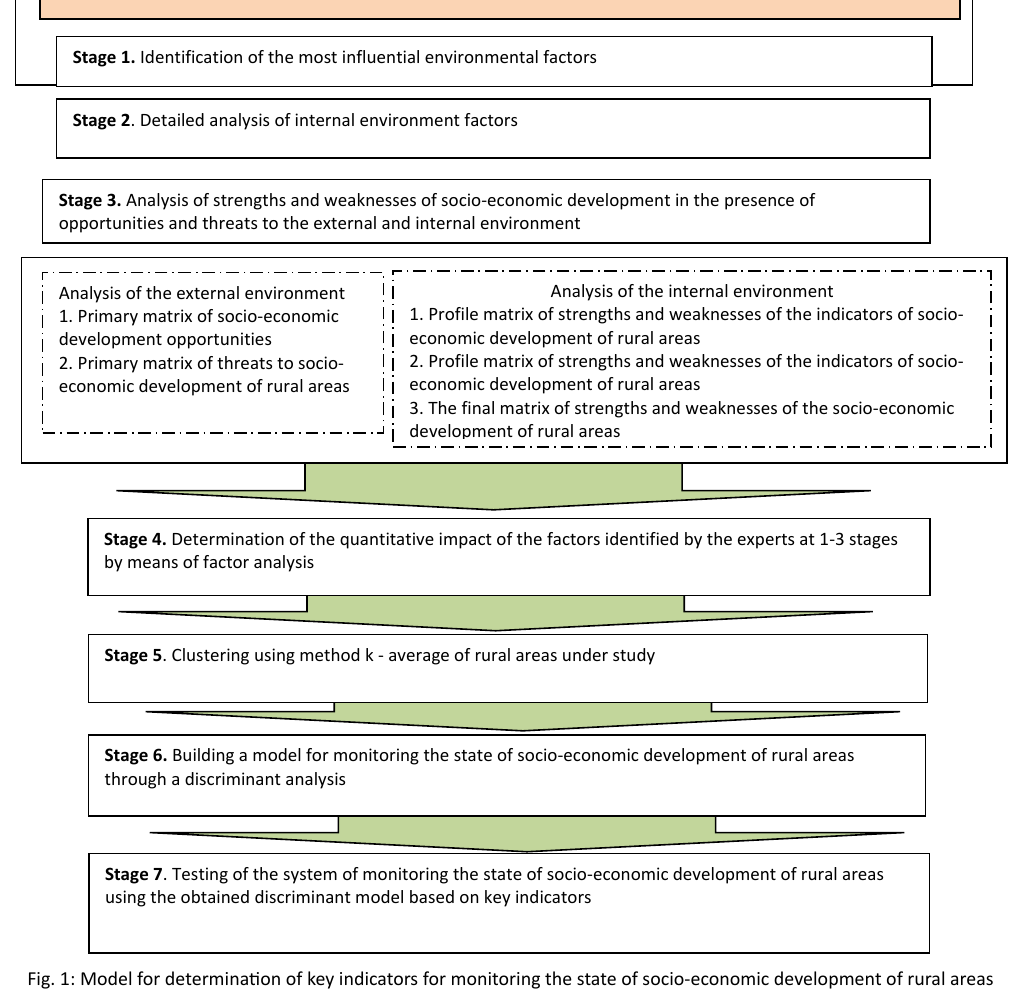
Fig. 1: Model for determination of key indicators for monitoring the state of socio-economic development of rural areas